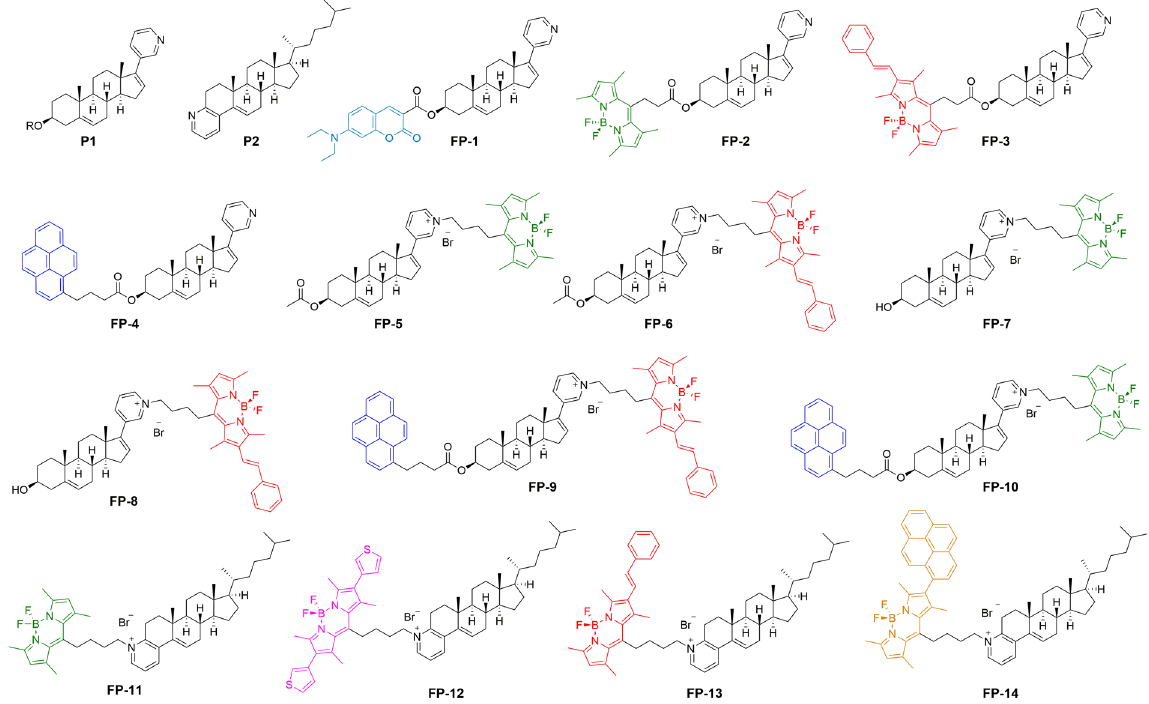
Figure 1. Heterocyclic precursors (P1 and P2) and synthetic probes (FP-1 ‒ FP-14) for sterol sensing. R = Ac,